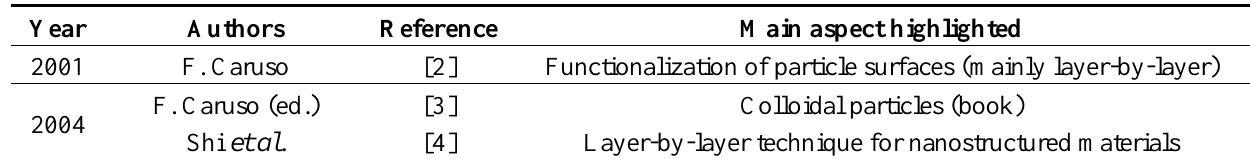
Table 1. Overview publication on specific issues related with the synthesis and applications of hybrid